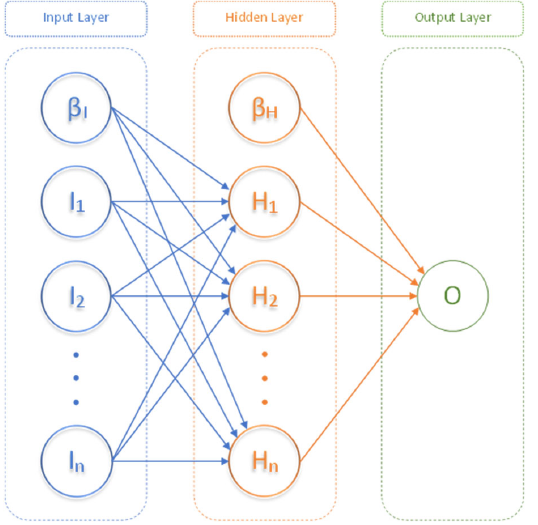
Fig. 1. Multilayer perceptron network with single hidden